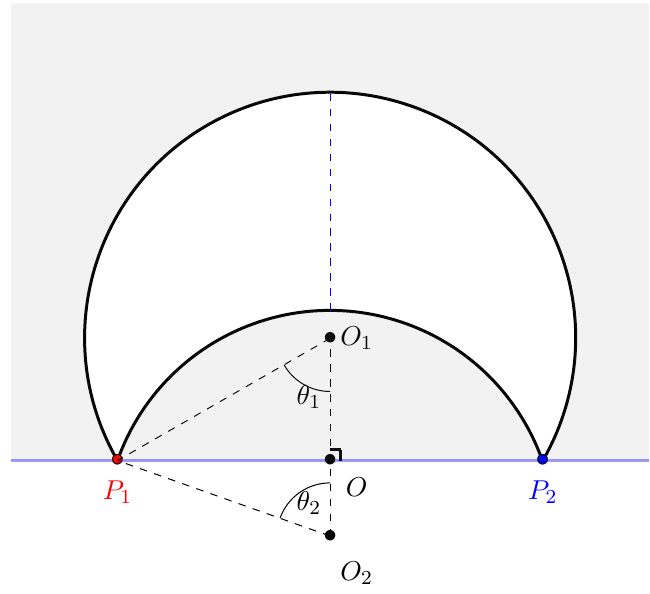
Figure 6. The brane configuration in the ( x, z ) coordinate. The shaded regions is the removed region in the bulk. The two black curves are the two branes and they are part of circles centered at O 1 and O 2 . The dashed blue line is the image of the BTZ black hole horizon and we emphasize that at t = 0 there is no black hole interior in our maximally extended